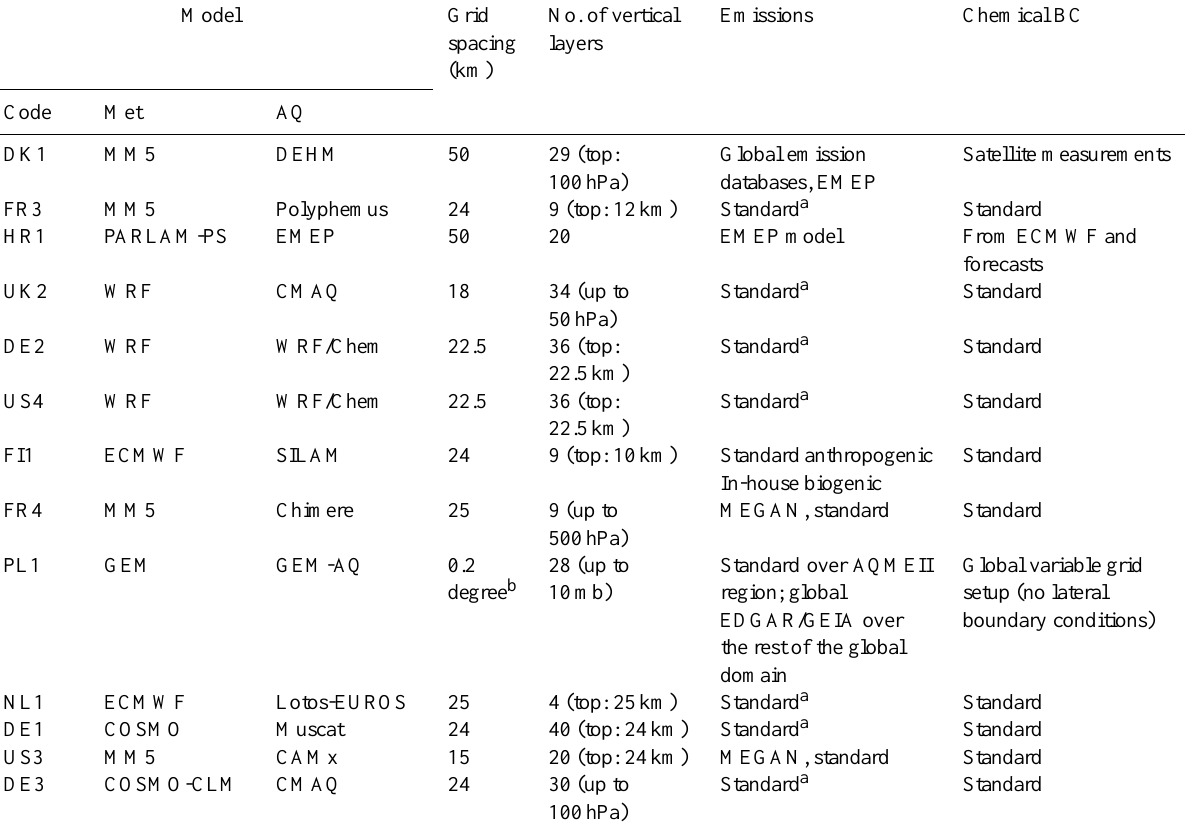
Table 2. Participating models and features.